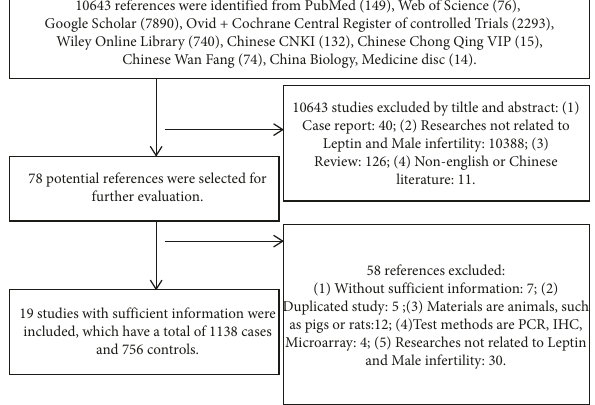
Figure 1: The flowchart of the search process with the number of screened, excluded, and included